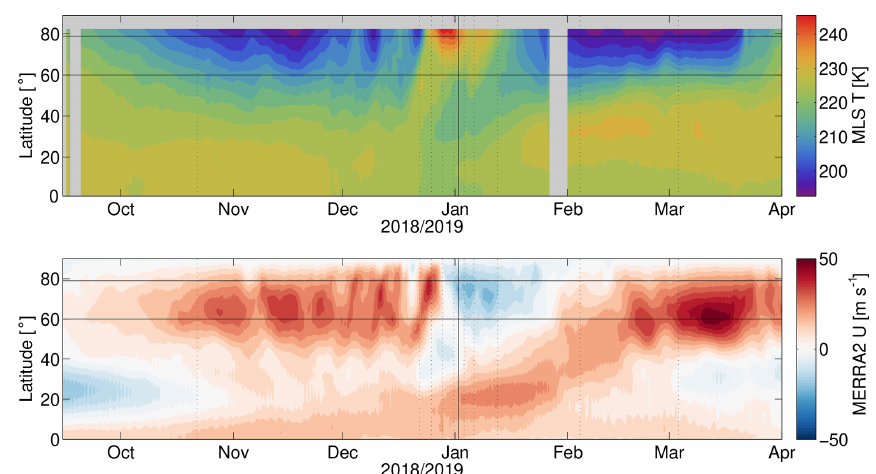
Figure 4. Zonal mean temperature from MLS and zonal mean zonal wind from MERRA-2 at 10hPa in the stratosphere for winter 2018/2019. The dotted lines indicate the dates of the polar vortex snapshots in Fig. 6 and the solid line shows the central date of the SSW. The horizontal lines indicate 60 and 79 ◦ N.